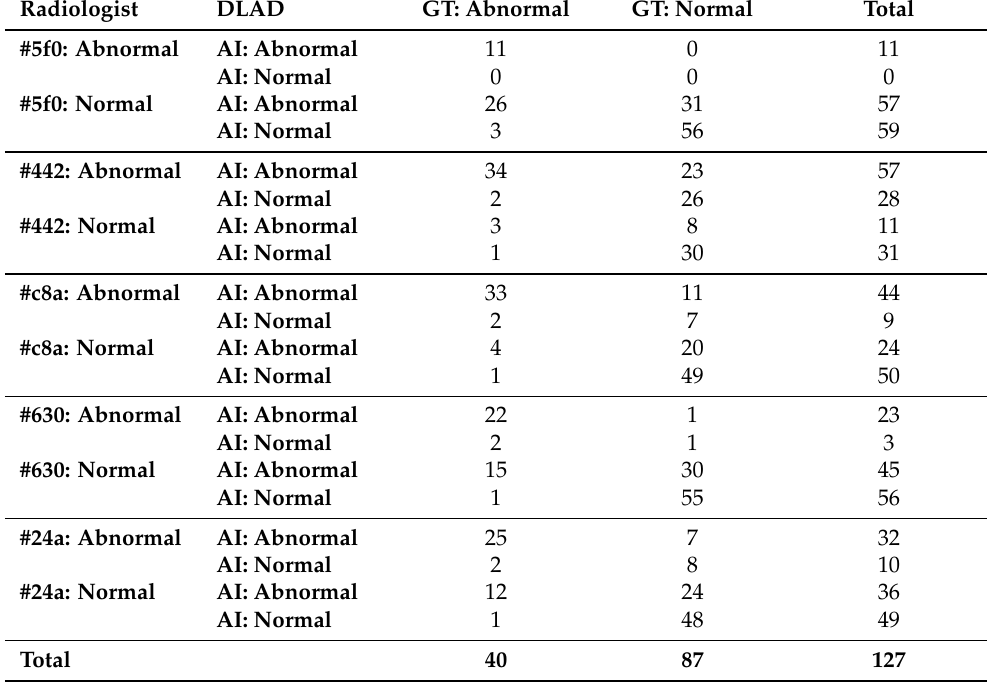
Figure 4. Forest plots for performance of DLAD and individual radiologists ( A ) sensitivity and specificity, ( B ) likelihood ratios, ( C ) predictive values. Table 5. Labeling of images by individual radiologists with respect to ground